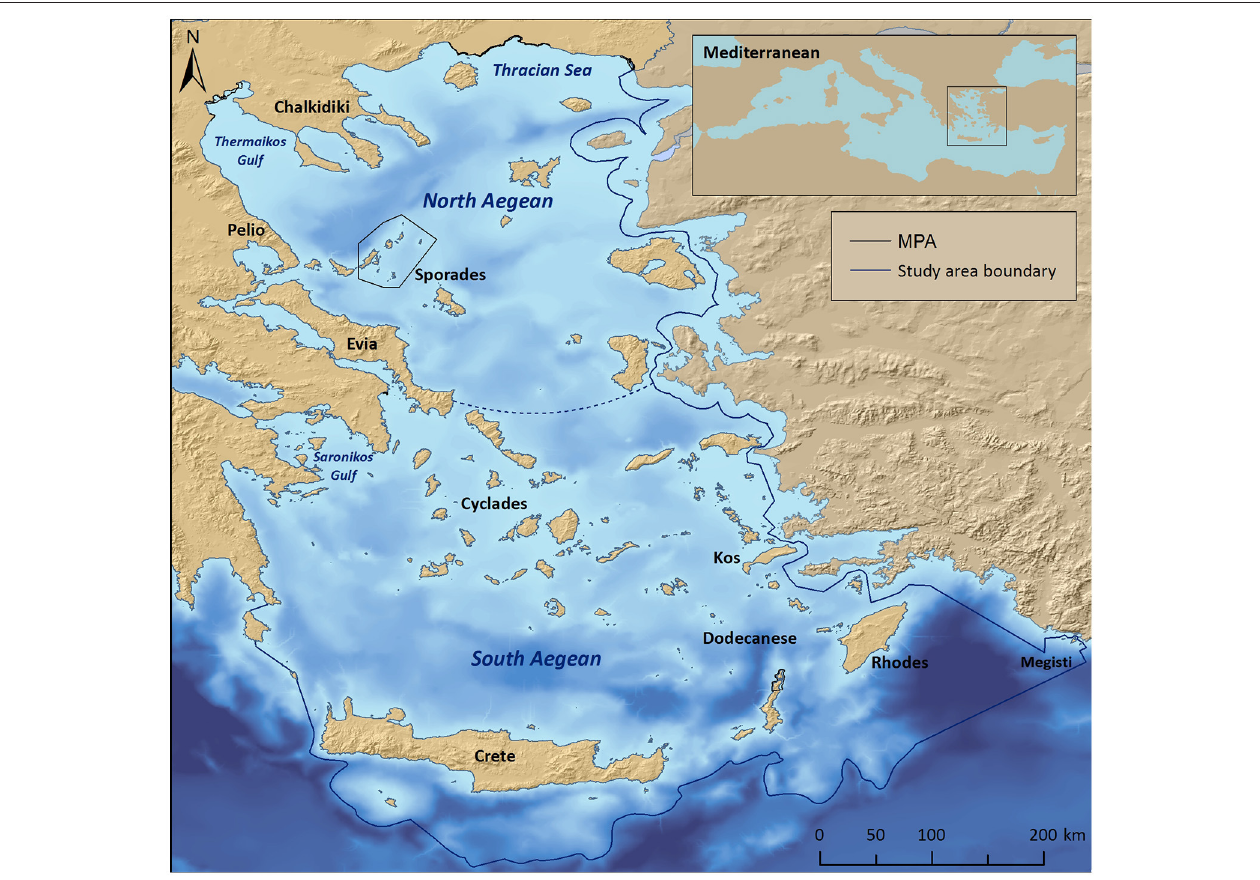
FIGURE 1 | Map of the Aegean Sea, depicting the study area boundary, the National Marine Park of Alonissos Northern Sporades, as well as other coastal MPAs. The dotted line indicates a notional delimiter between the North and South Aegean